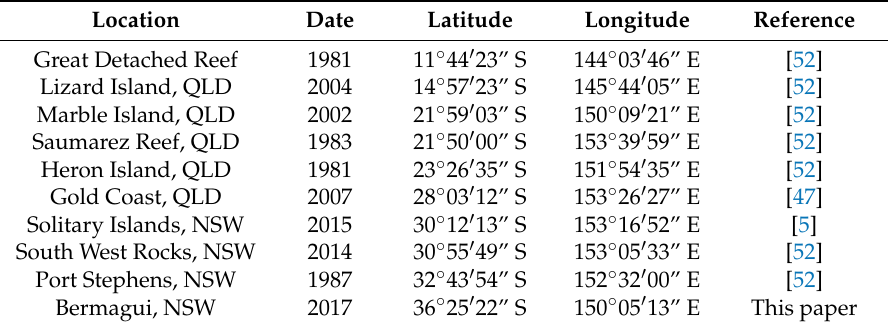
Table 3. Distribution records of Haminoea cymbalum from eastern Australia.